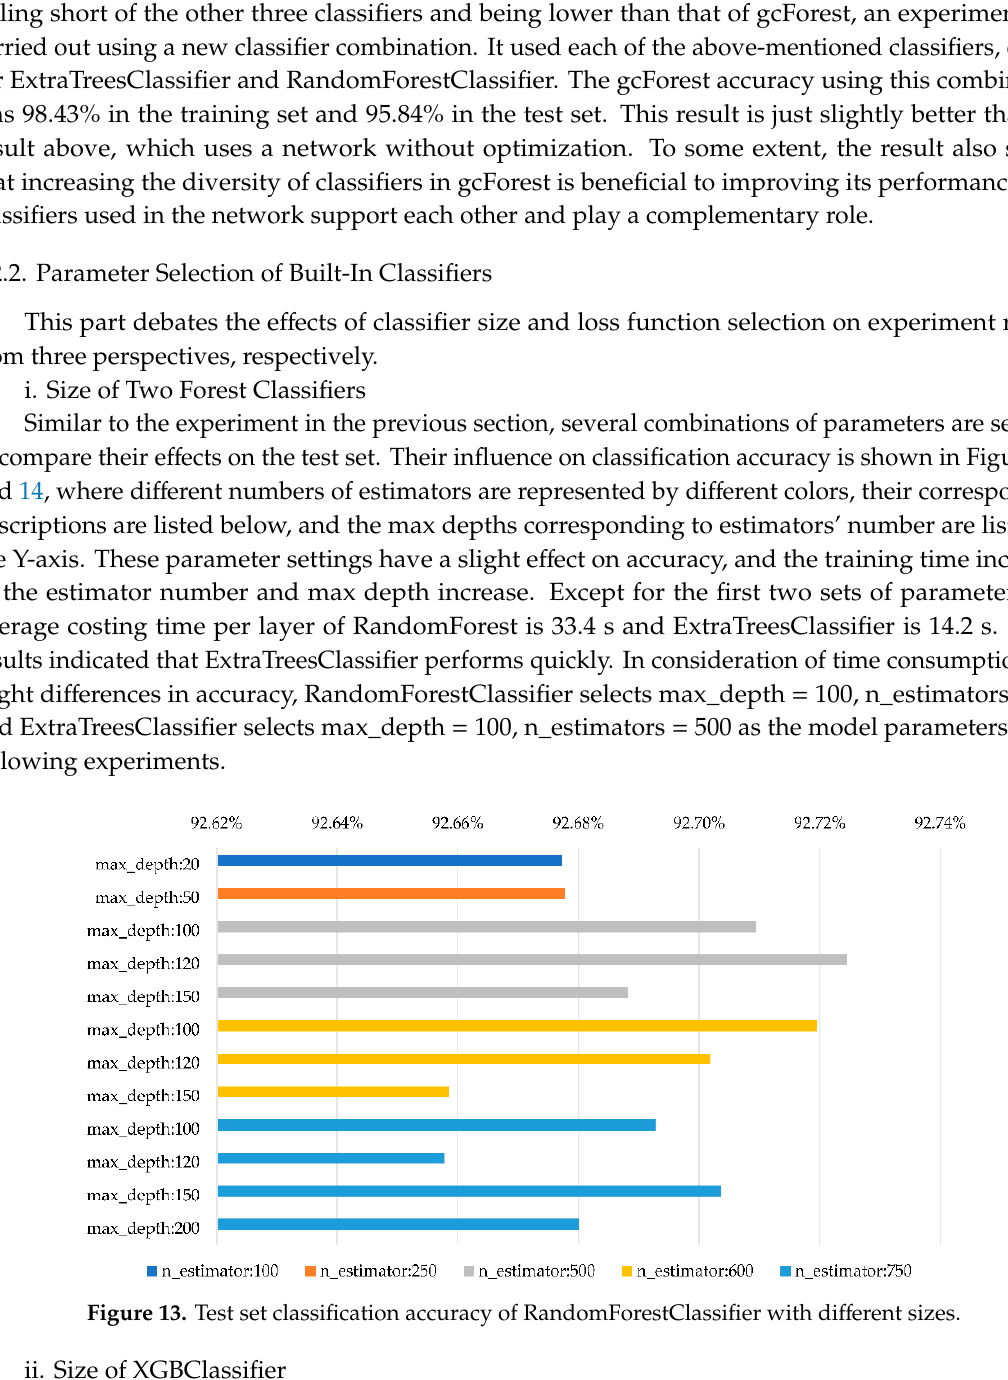
Figure 12. Test set classification accuracy of gcForest and its built-in classifiers in each layer.